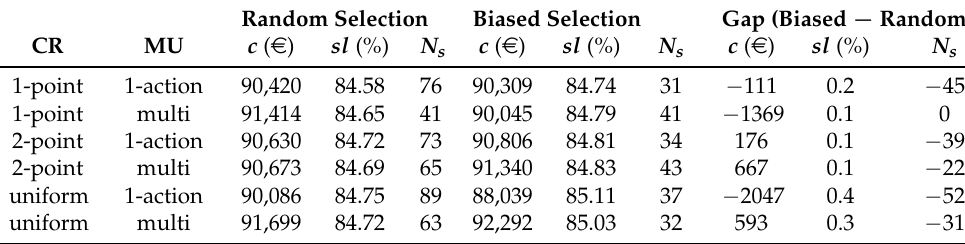
Table 3. Comparison between random selection of actions and biased selection in an evolutionary algorithm (EA) experiment using the gap analysis (CR = crossover form, MU = mutation